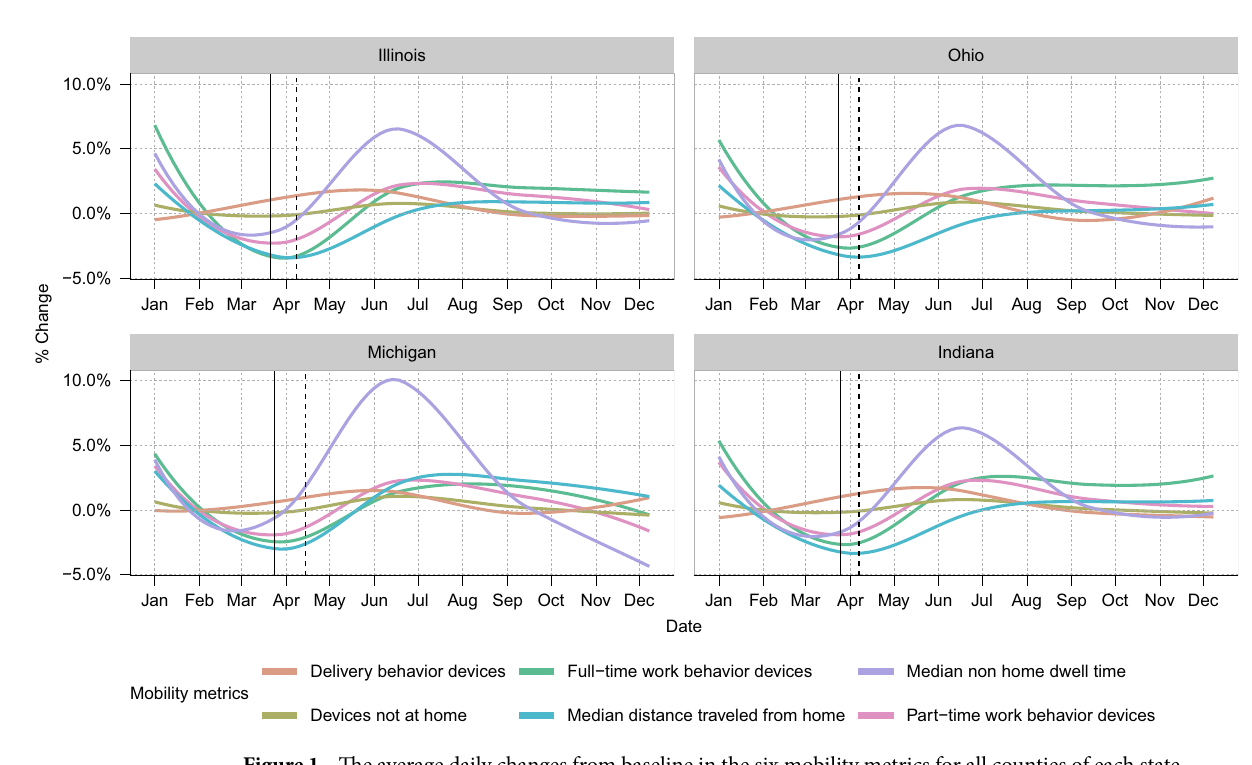
Figure 1. The average daily changes from baseline in the six mobility metrics for all counties of each state between January and December 2020. The baseline was calculated using a rolling average of the 7 previous days. The solid vertical lines represent the date the stay-at-home orders were put in place while the dotted vertical lines represent the dates the stay-at-home orders were lifted.